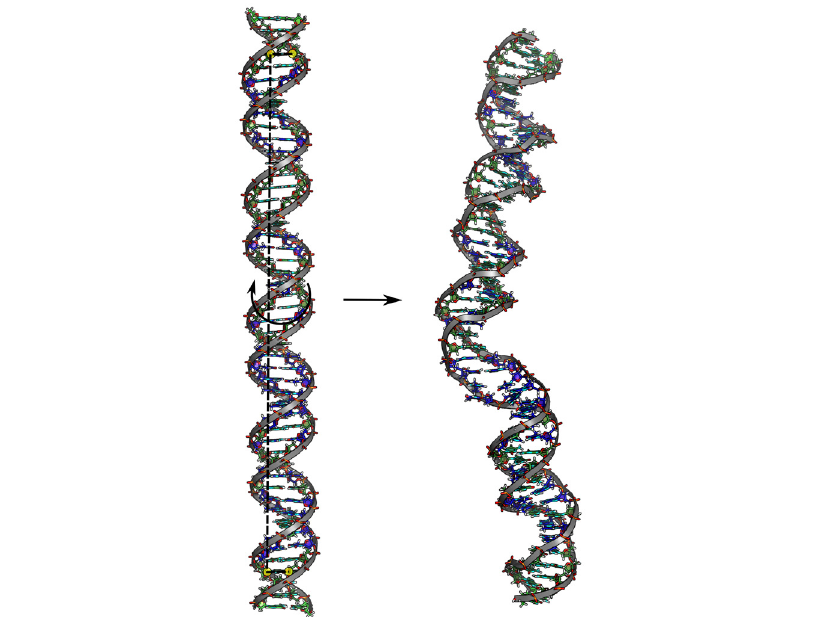
Fig 3. Setup of the simulation systems (as stick models with the backbone indicated as cartoon). Yellow circles indicate positions of the C1’ atoms (4th and 47th bp), which constitute the torsional reaction coordinate, illustrated as dashed line (unwinding is indicated as curved arrow in the middle of the left panel). Step-wise unwinding eventually leads to melting of the TATA-box segment (located in the lower half of the DNA molecule, right panel). C/G bases are shown in green, A/T bases in